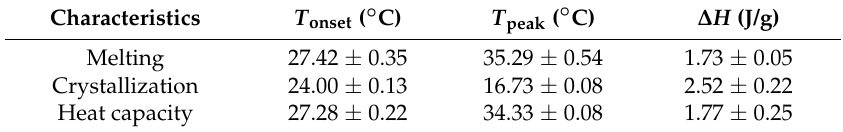
Table 2. T onset , T peak and ∆ H values obtained from melting, crystallization and heat capacity of